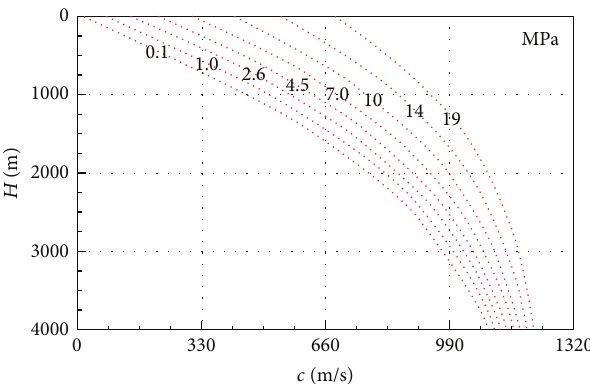
Figure 4: Wave velocity distribution at different BP.